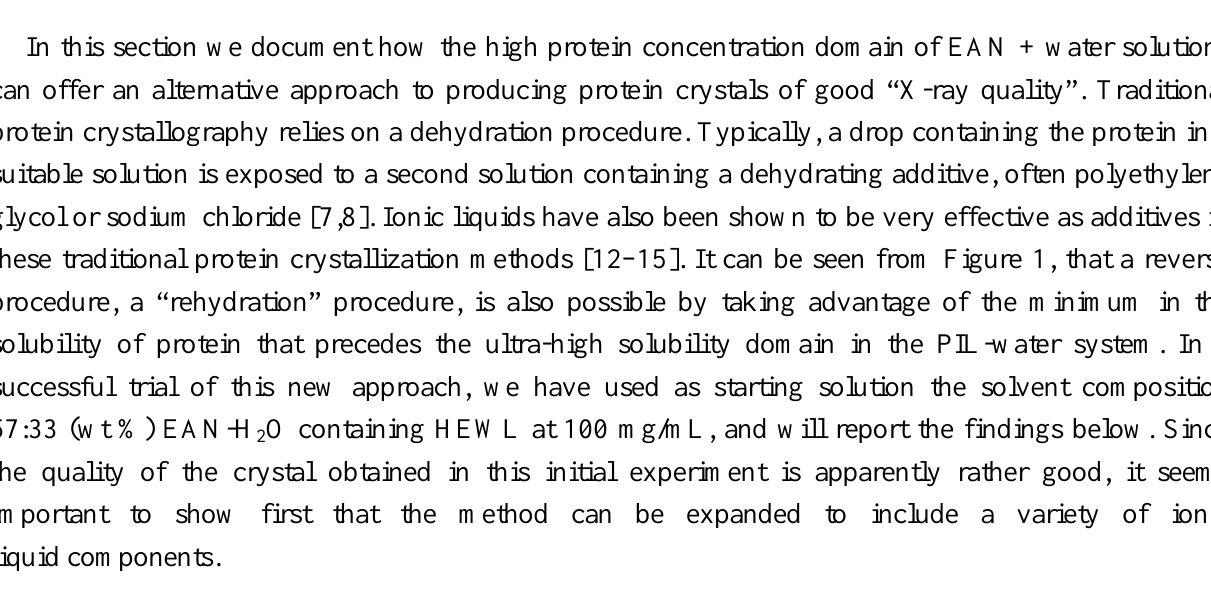
Figure 3. Solubility curves for Hen lysozyme, HEWL, dissolved in a) TEAMS and b)